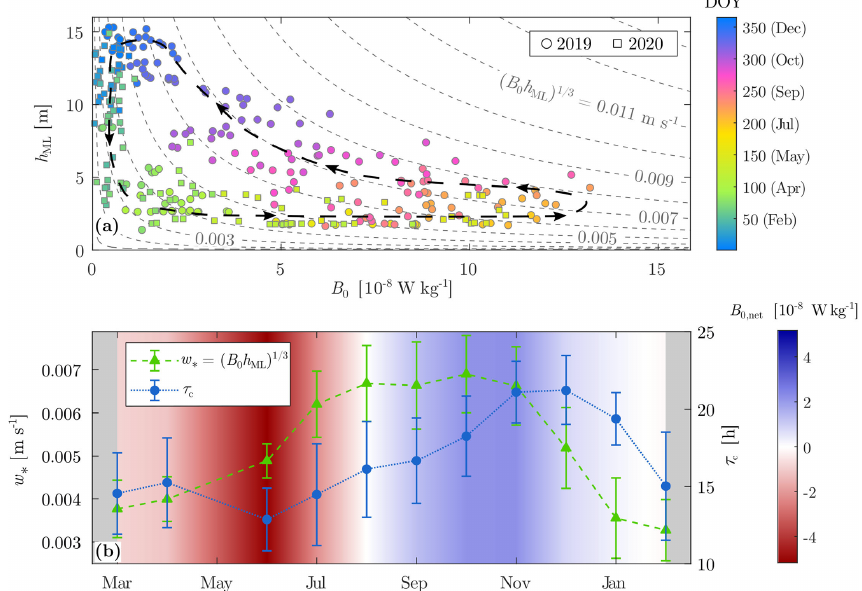
Figure 4. Seasonal variability in the forcing parameters over 1 year (from March 2019 to March 2020). (a) Daily averages of mixed-layer depth as a function of surface buoyancy flux during cooling periods. Gray dashed lines indicate the corresponding convective velocity scale. The black dashed line with arrows is a qualitative representation of the annual cycle. (b) Monthly averages of convective velocity scale w ∗ during the cooling phase (green line), duration of the cooling phase τ c (blue line), and net surface buoyancy flux B 0 , net (linearly interpolated color map). Error bars represent the standard deviation of w ∗ and τ c